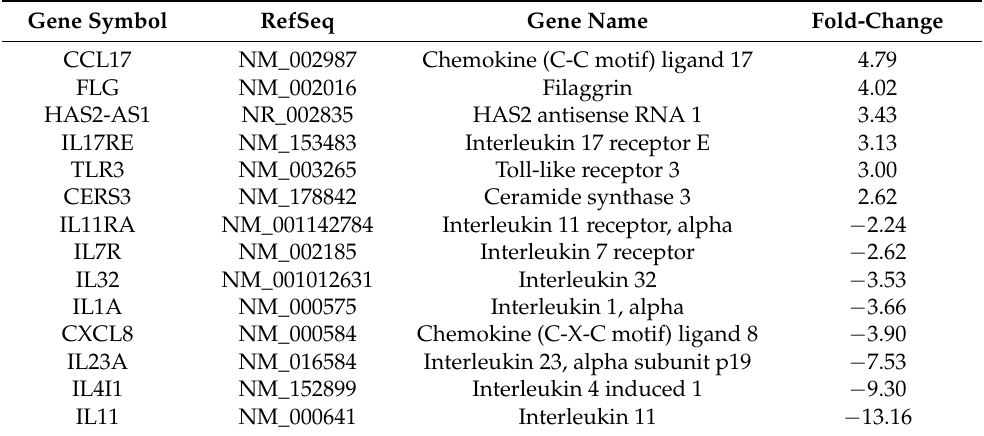
Figure 2. Differential expression of genes in resvebassianol A- and RSV-treated keratinocytes. ( A ) Hierarchical clustering of altered mRNA. Microarray analysis for mRNA expression patterns of platelet heatmap of deregulated mRNAs, which were two-fold upregulated or downregulated. ( B ) Volcano plotting microarray analysis revealed the mRNAs that were two-fold upregulated or downregulated in platelet during storage. Table 2. Upregulated or downregulated genes in resvebassianol A-treated keratinocytes compared to those in RSV-treated